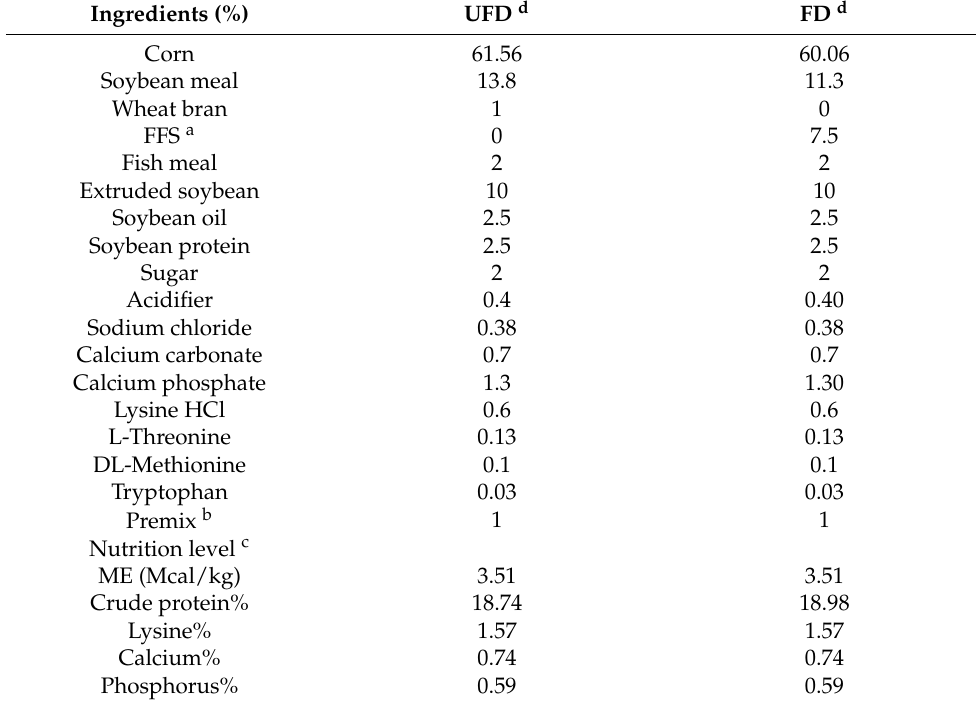
Table 1. Composition and nutrient levels of the control and treatment diet (% as fed).